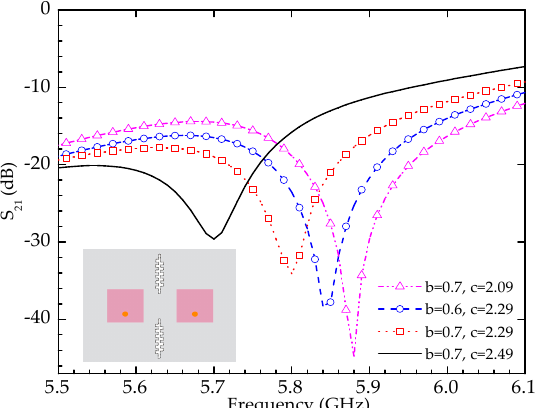
Figure 6. Isolation at 5.8 GHz varying with di ff erent sizes of b and c when a = 1.29, k = 1.8, L 2 = 1.685, and W 2 = 0.5 (unit, mm).